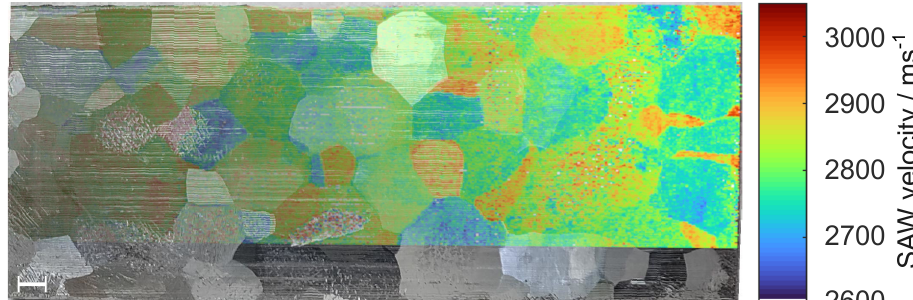
Figure 8. Optical micrograph of an etched Ti-6246 sample with overlay of velocity map, taken with 16 averages per point. The scale bar shown in the lower left-hand corner indicates 5mm. The transparency of the velocity map is used to allow the etched grain structure to be shown for